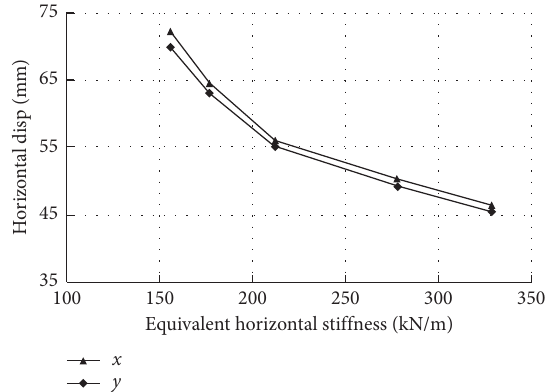
Figure 21: Seismic coefficient related to postyield stiffness.